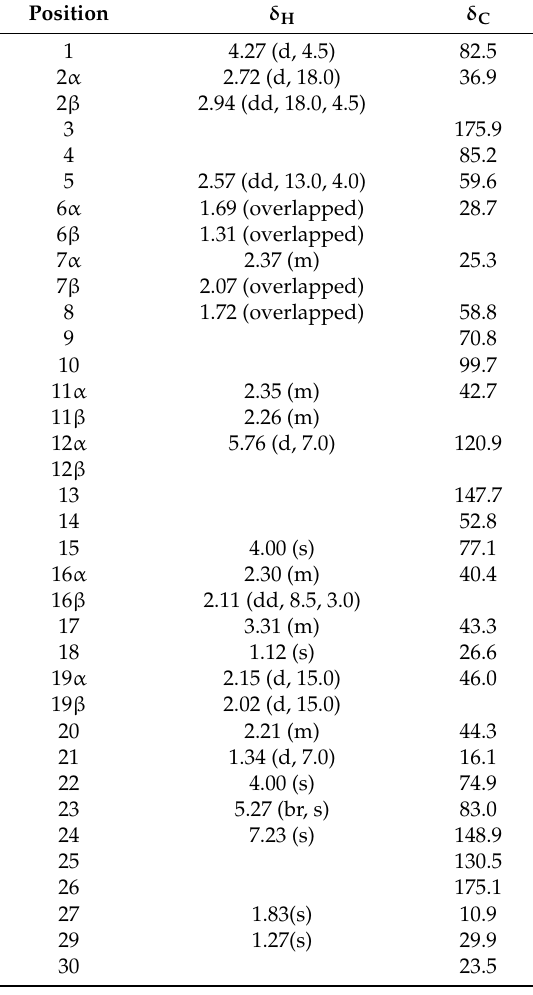
Table 1. 1 H- and 13 C-NMR data for micrandilactone H in pyridine- d 5 using an INOVA-500 MHz spectrometer.